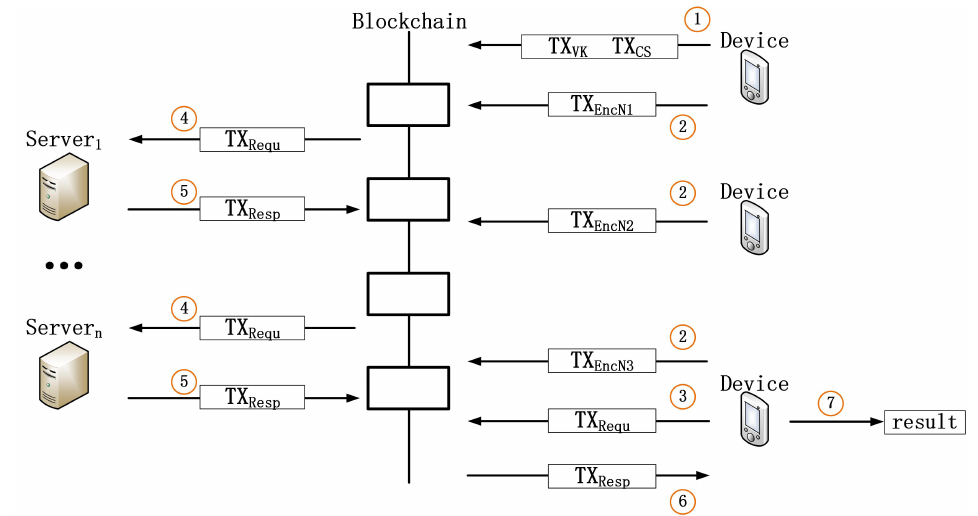
Figure 1. An overview of BeeKeeper 2.0. TX VK , TX CS , TX EncN , TX Requ and TX Resp are